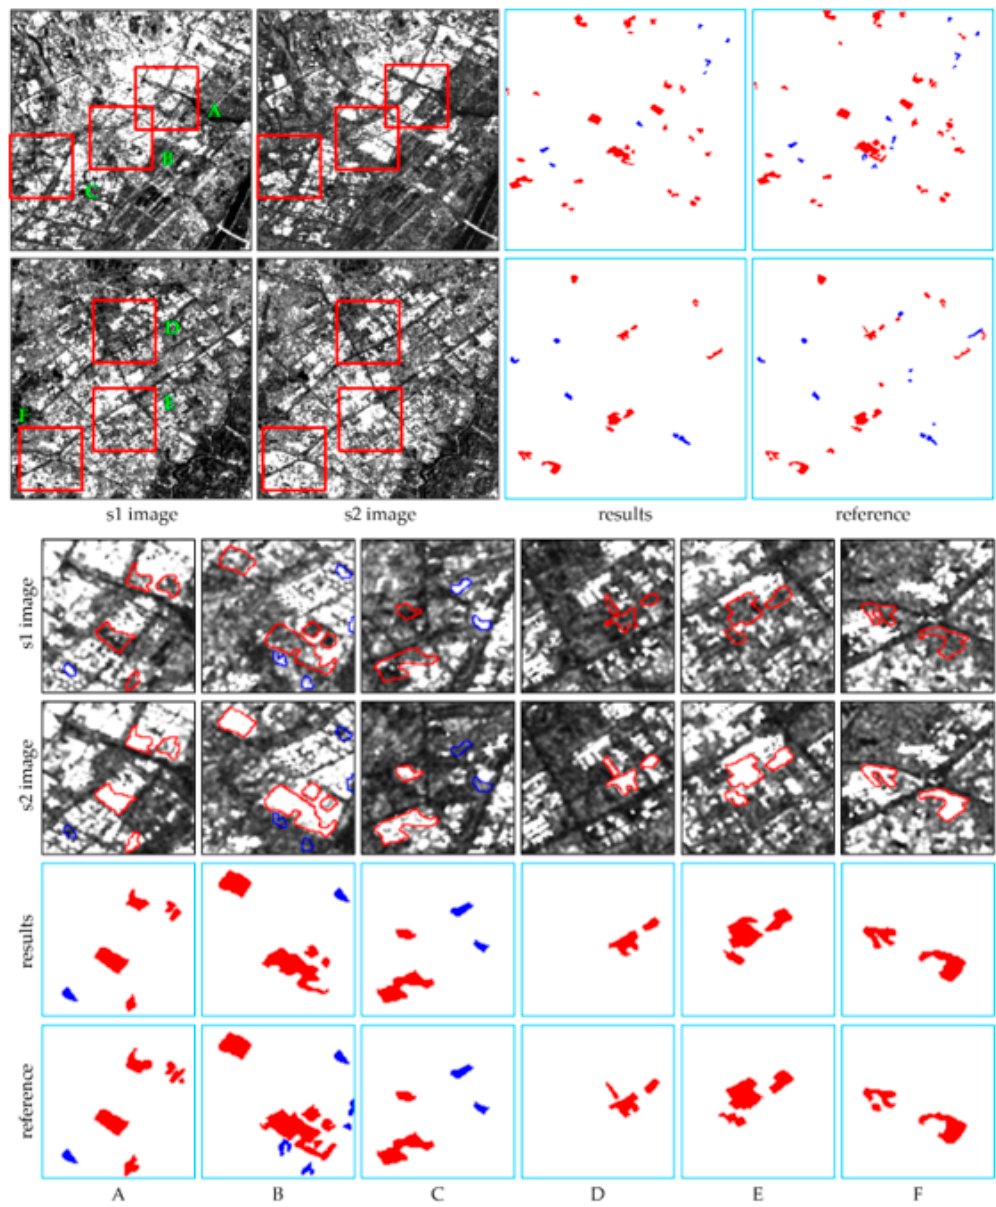
Figure 7. The building change results at Pukou District and Chunxi Town from 16 March 2017 to 22 January 2018. Pixels in red indicate newly constructed buildings and pixels in blue indicate removed